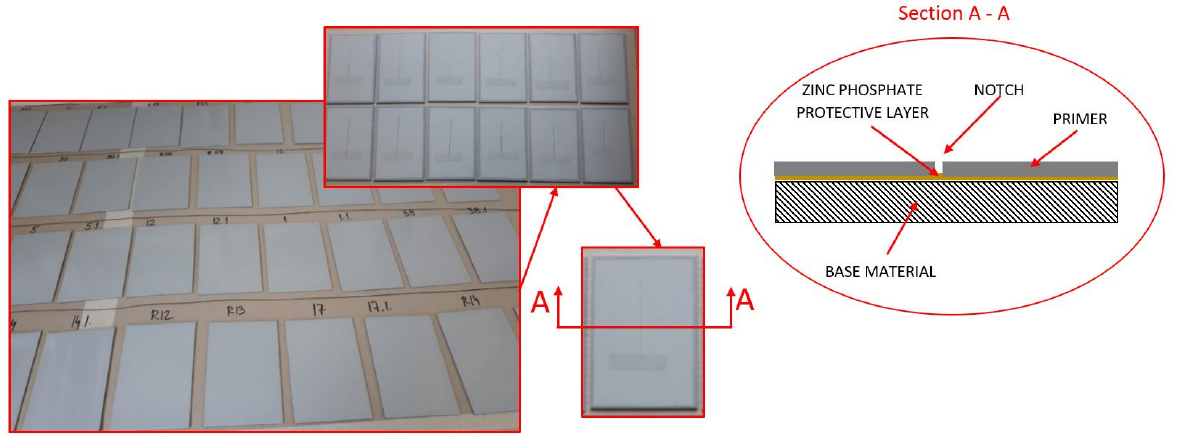
Figure 1. Protective mechanism of the primer with zinc phosphate anticorrosive pigment. Conditioning time refers to the period of time that is required after applying the coating on the base material, so that the coating can achieve satisfactory cohesion forces within the coating itself, as well as between the coating and the base material surface. If there is anticorrosive pigment contained in the coating, the satisfactory conditioning time also represents the period required for the creation of quality chemical compounds at the layer between the base material and the coating, i.e., for the creation of phosphates that inhibit corrosion mechanisms. In order to achieve the best possible results, authors have tested various conditioning time values. They start with testing for 24 h at room temperature, adding 8 h at 60 ± 2 ◦ C [34], or 24 h at 25 ◦ C, with an additional 24 h at 60 ◦ C [35]. Slightly higher conditioning times for the testing of coatings are 5 days [36], 7 days [32], and 7 days at room temperature with one additional day at 100 ◦ C